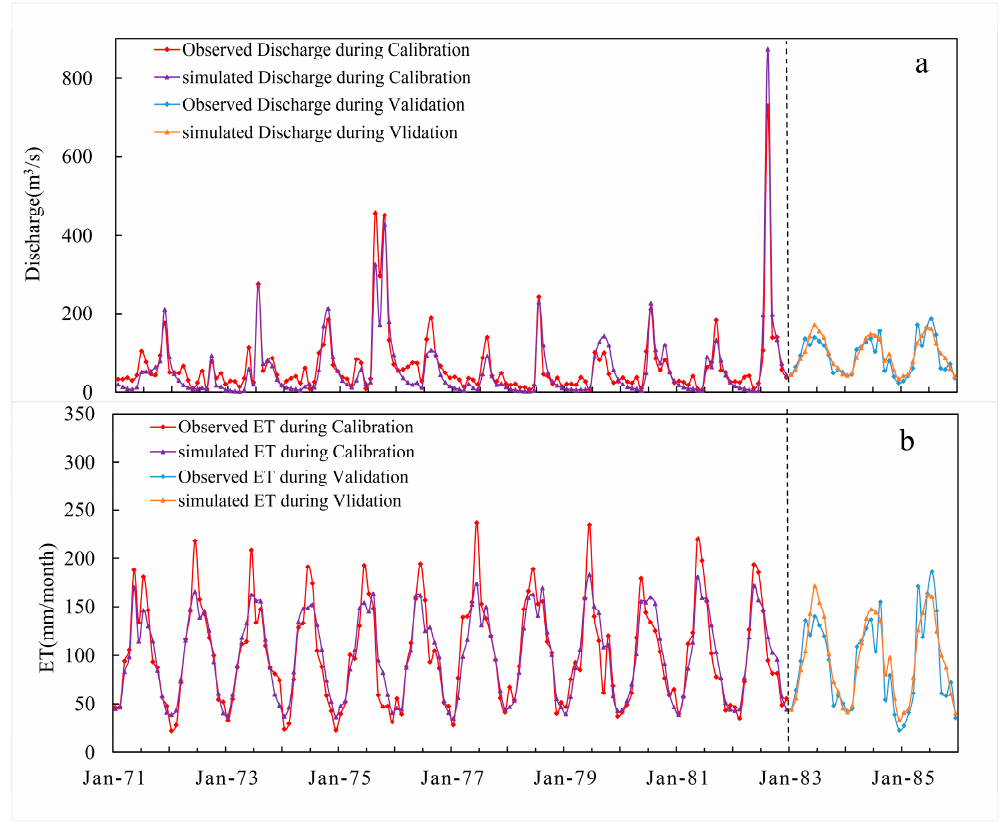
Figure 5. Simulated and observed monthly ( a ) discharge and ( b ) actual evapotranspiration ( ET ) during